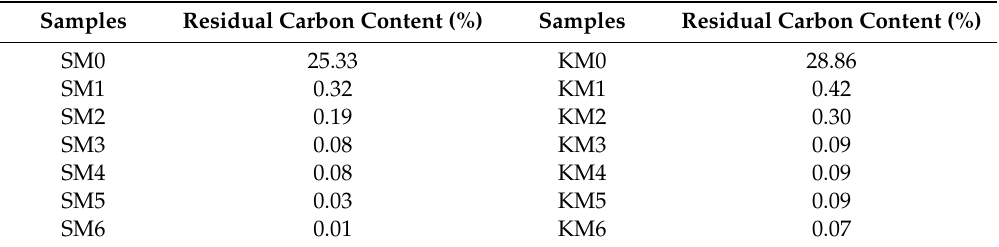
Table 2. Residual carbon content in the SBA-15 and KIT-6